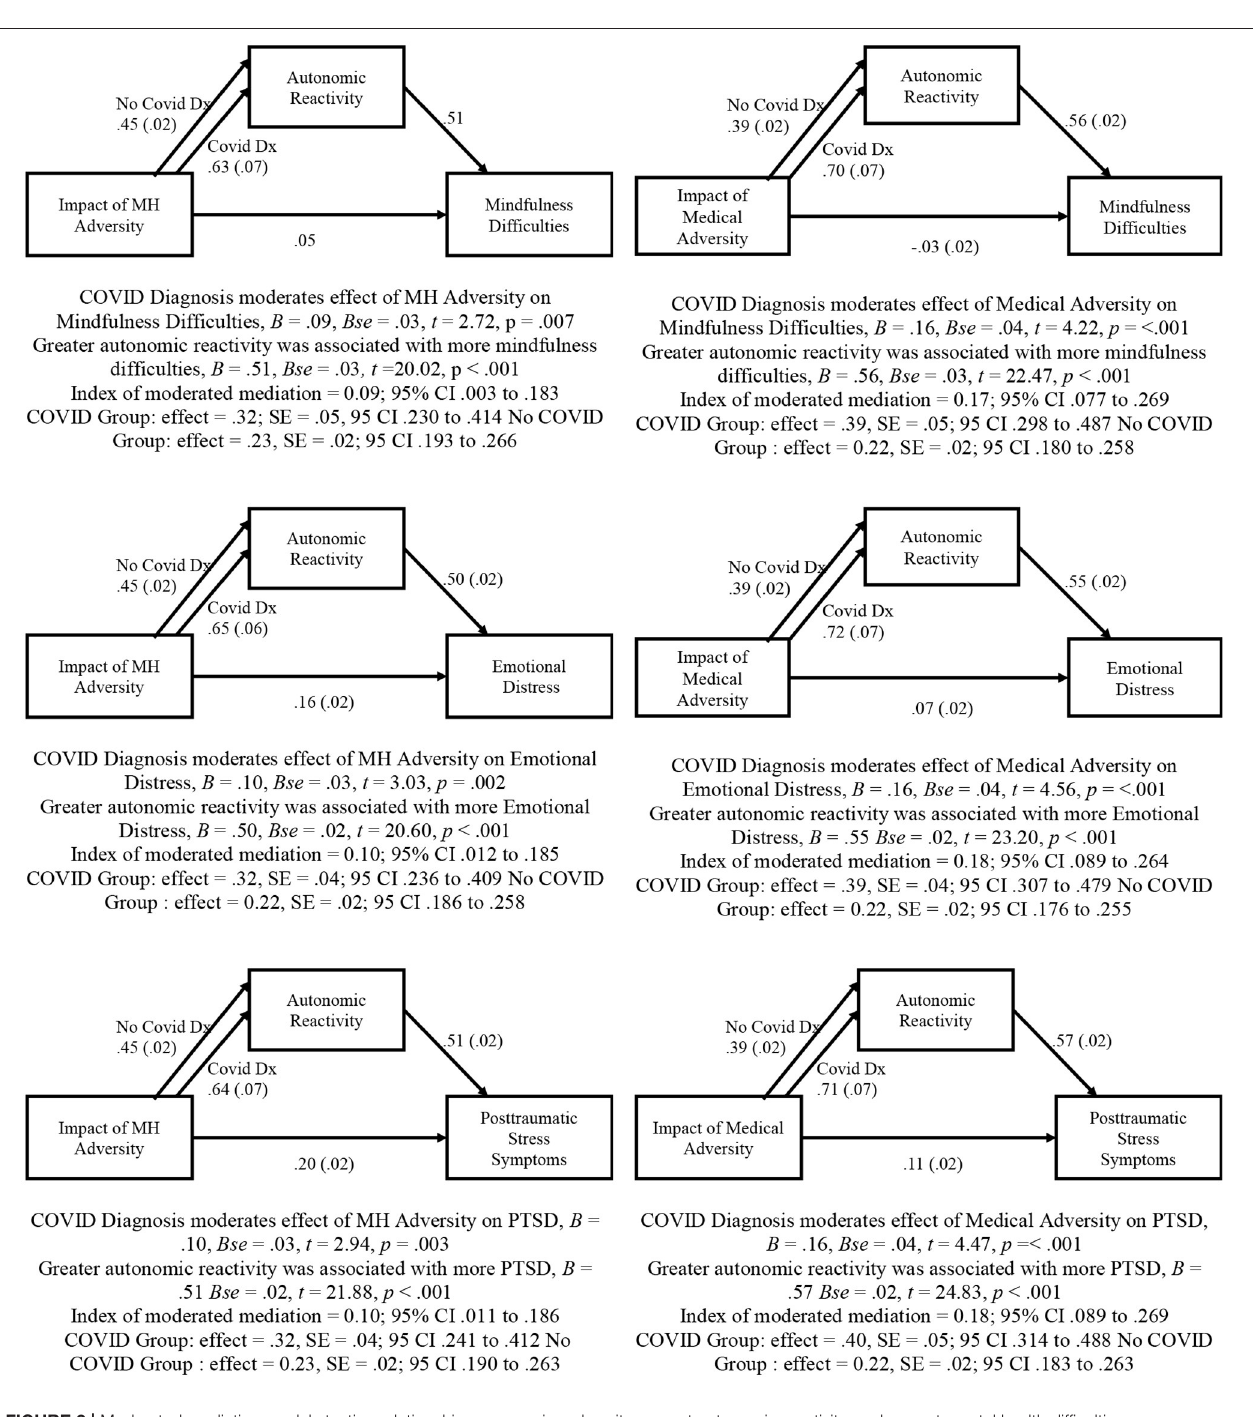
previously diagnosed had higher levels than those not diagnosed with COVID-19, which is consistent with prior findings that changes in the ANS may persist after the infection has dissipated